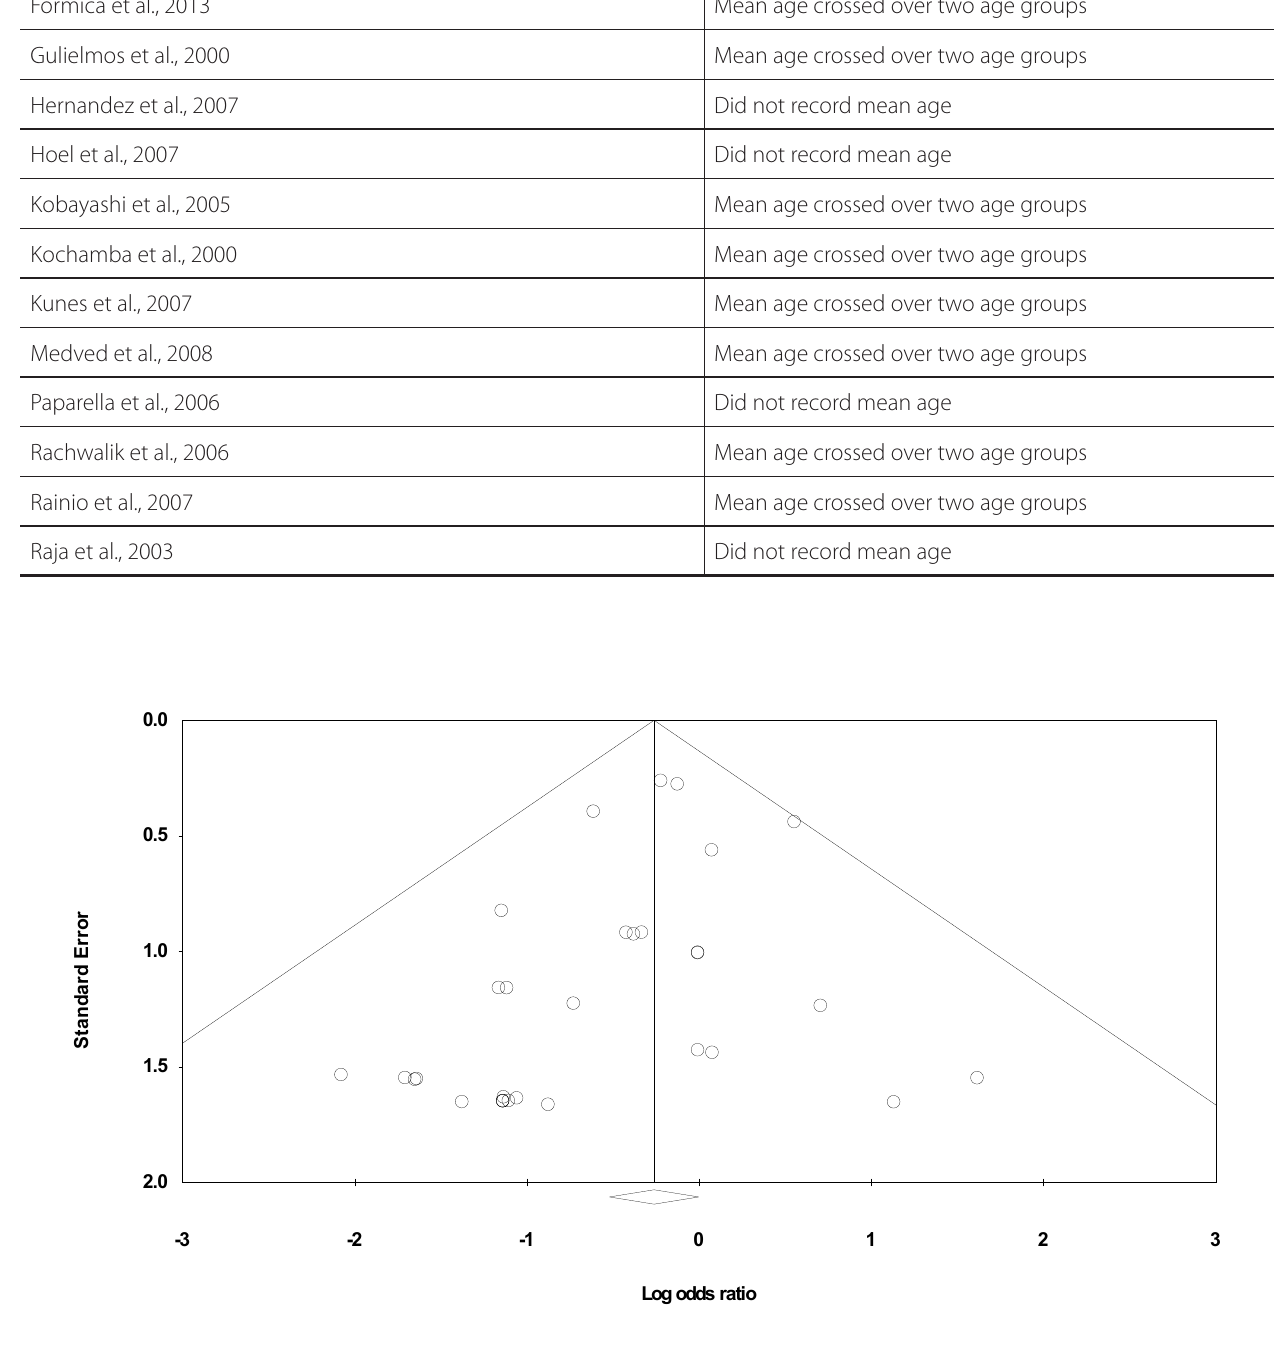
Supplementary Fig. 2 – Funnel plot for the incidence of stroke. Begg and Mazumdar’s test (P value): 0.262 and Egger’s test (P value):